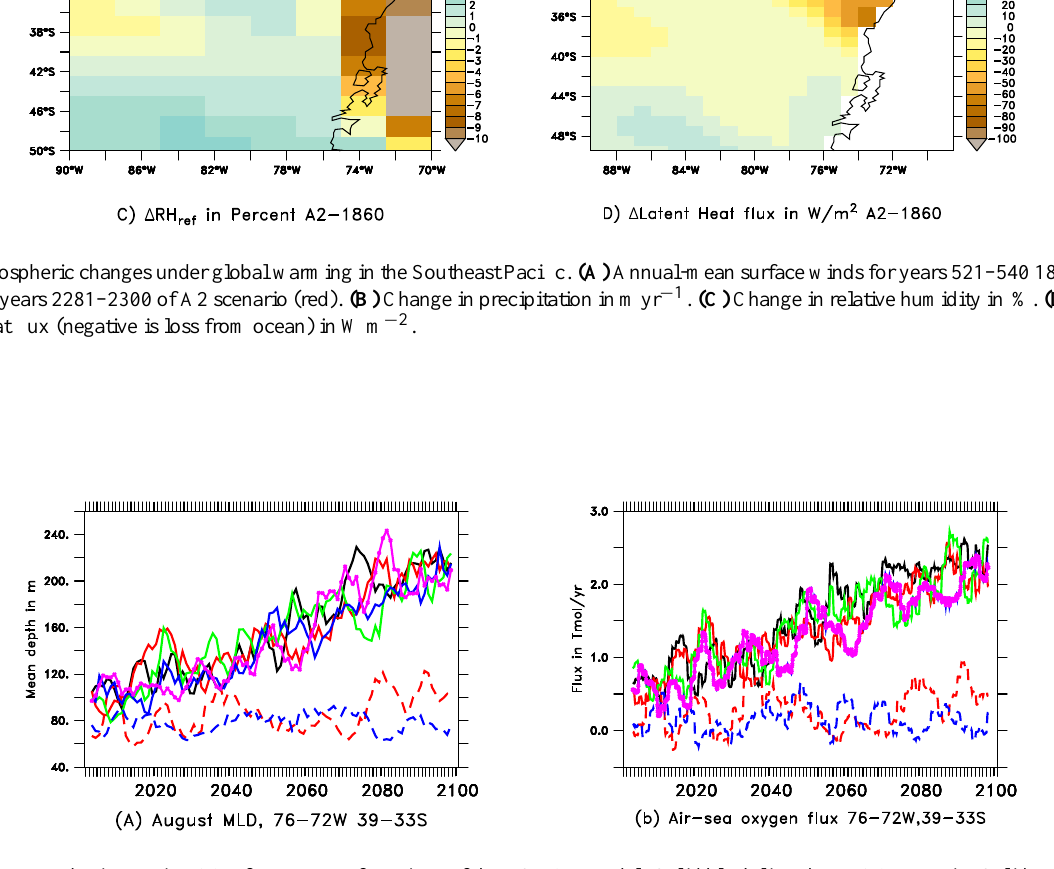
Fig. 8. Changes under increasing CO 2 for a range of versions of the ESM2.1 model. Solid black line shows A2 scenario. Solid colored lines show simulations using the A1B scenario where CO 2 affected radiation balance but not necessarily ocean or land biogeochemistry (lines 4–7, Table 1). Dashed colored lines show simulations where CO 2 affects biogeochemical cycling (through acidification or terrestrial carbon fertilization, lines 8 and 9 of Table 1) but not radiation. (A) Monthly-mean mixed layer depth for August, five-year boxcar smoothed for all ocean grid points between 76 ◦ W–72 ◦ W and 39 ◦ S–33 ◦ S. (B) Five-year smooth of air-sea flux of O 2 in Tmol yr − 1 for same region. Lines as in